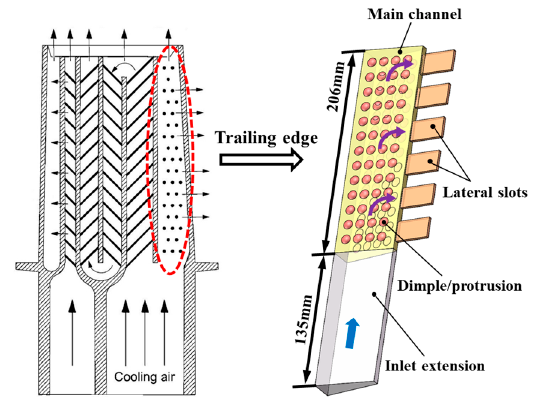
Figure 1. Typical internal cooling structure of turbine blade (left) [8] and the trailing edge cooling channels studied in this paper (right).